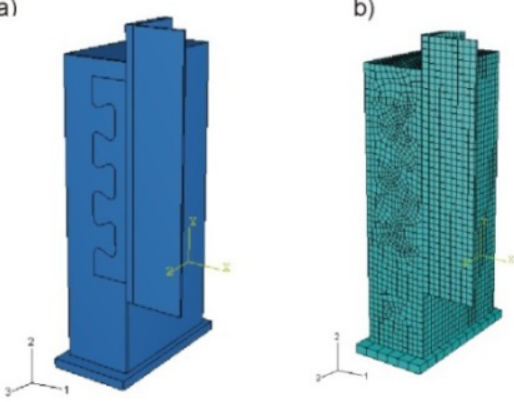
Figure 20: Numerical model of the so-called “crestbond” connector [10] studied for purposes of [7]: a) the geometry of solid model using ¼ symmetry, b) the net of finite elements used in the model for nonlinear analysis.